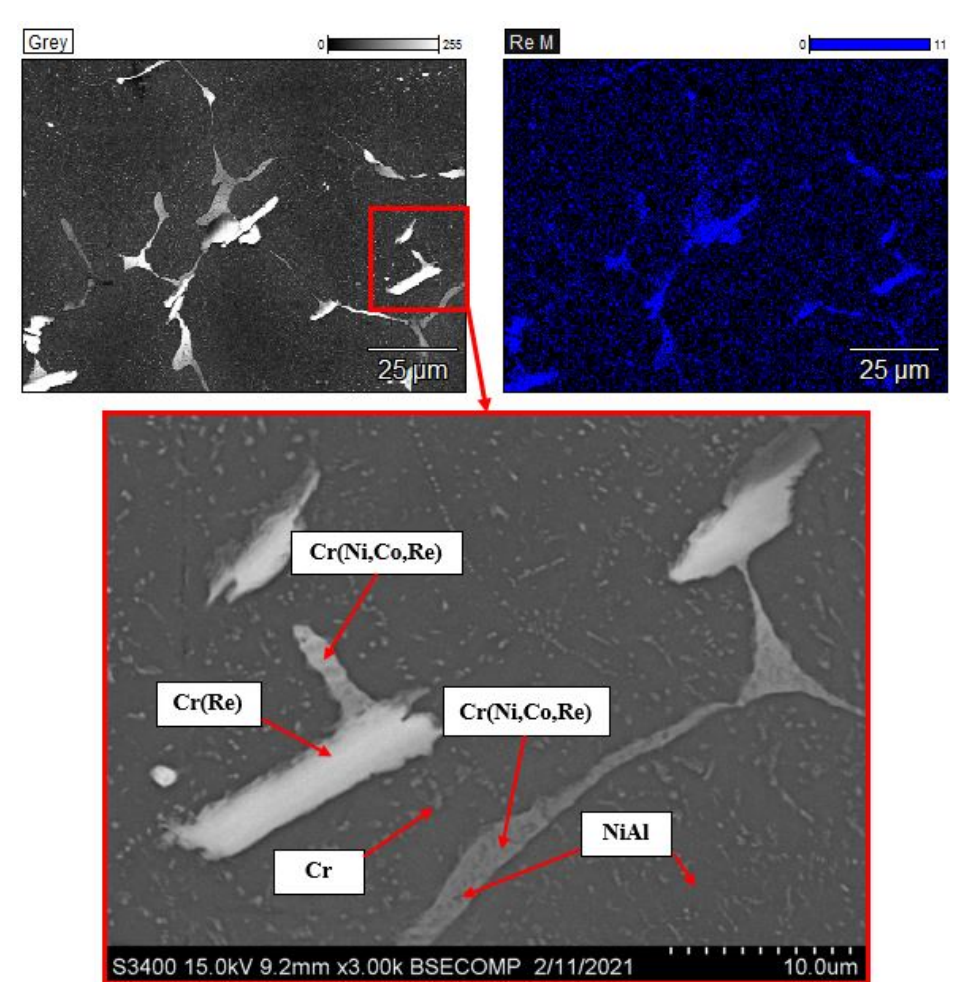
Figure 9. The microstructure of the alloy doped with rhenium (1.5%) and the map of dopant distri- bution.